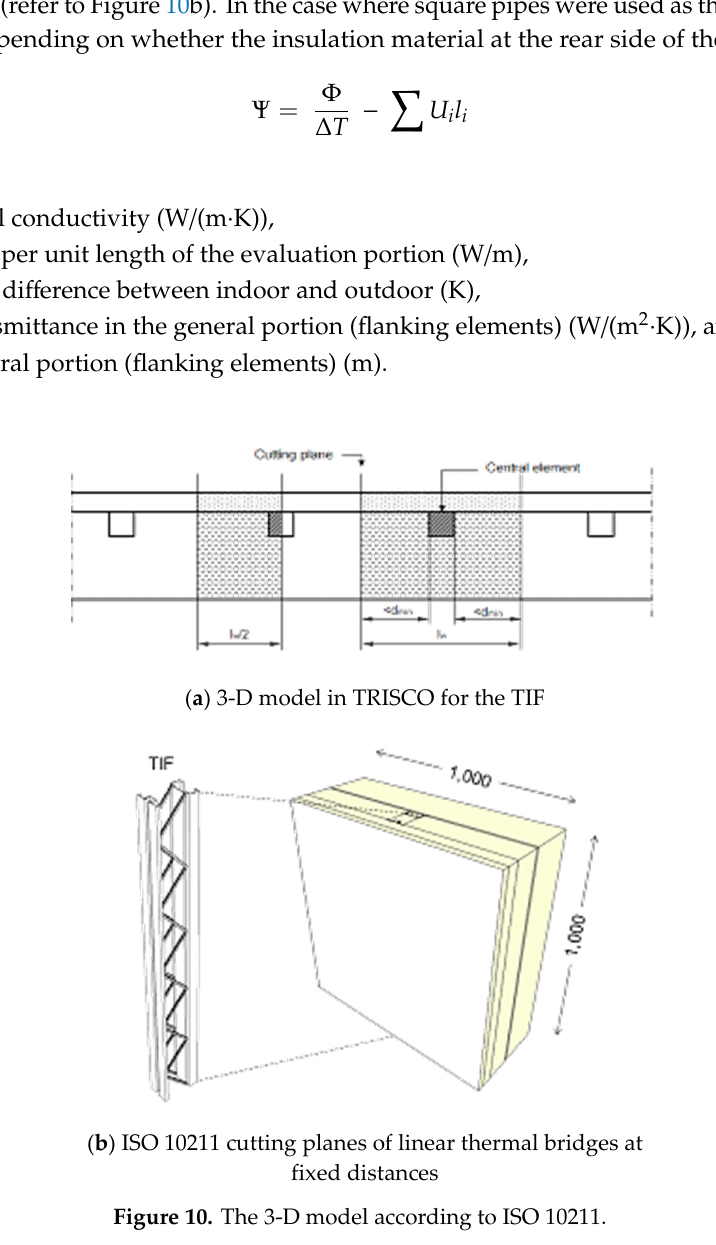
Figure 10. The 3-D model according to ISO 10211.